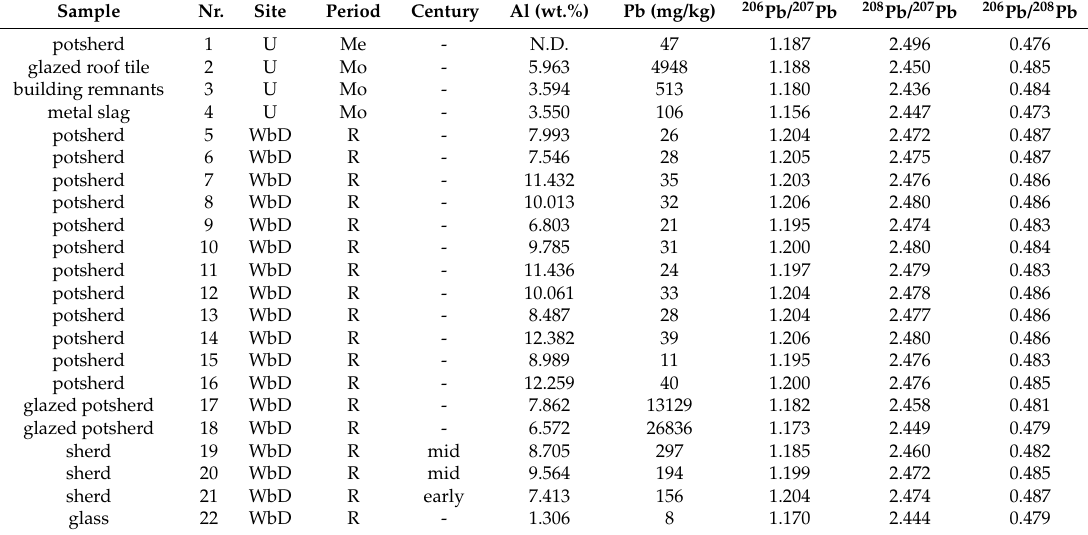
Table 3. Analytical results of the (potential) anthropogenic Pb sources (Pb